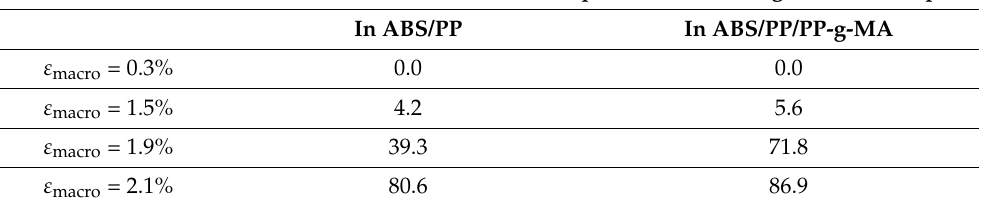
Table 4. Percentage of elements in ABS with an equivalent stress higher than the ABS strength for ABS/PP and ABS/PP/PP-g-MA blends.